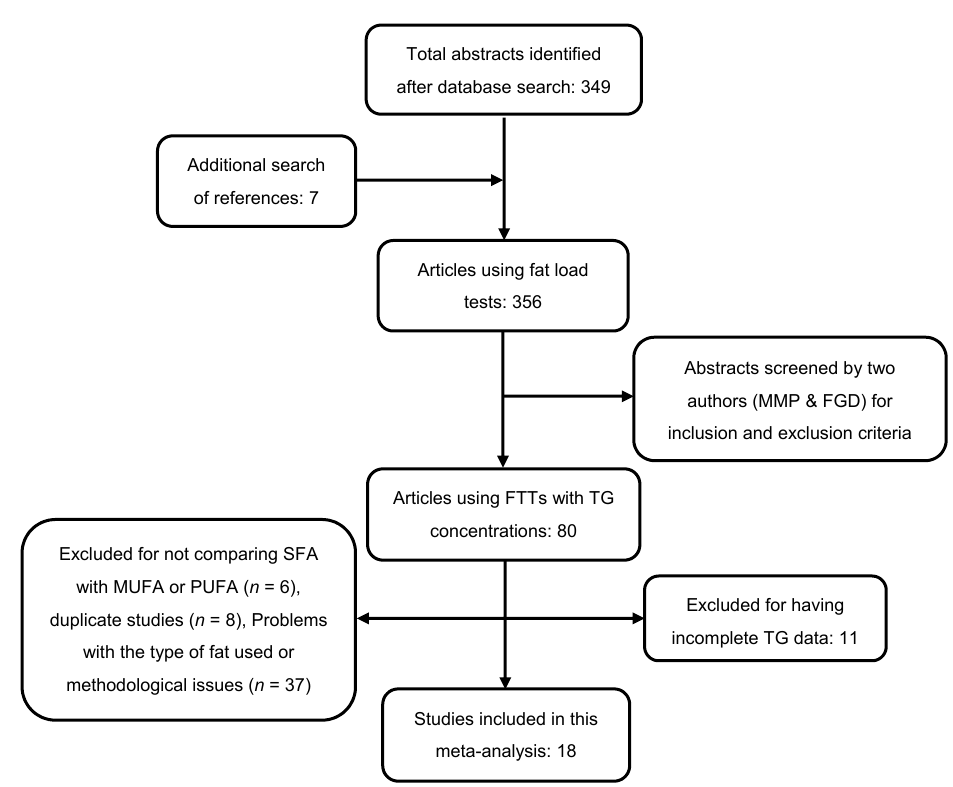
Figure 1. Flowchart of the systematic search strategy and study selection process.